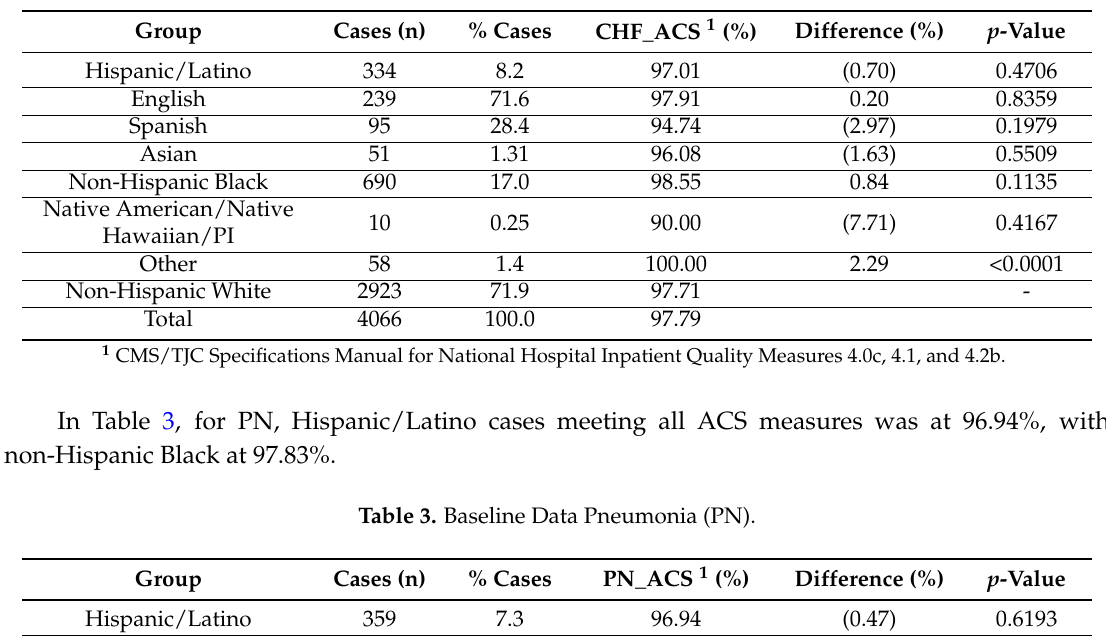
Table 2. Baseline data congestive heart failure (CHF).